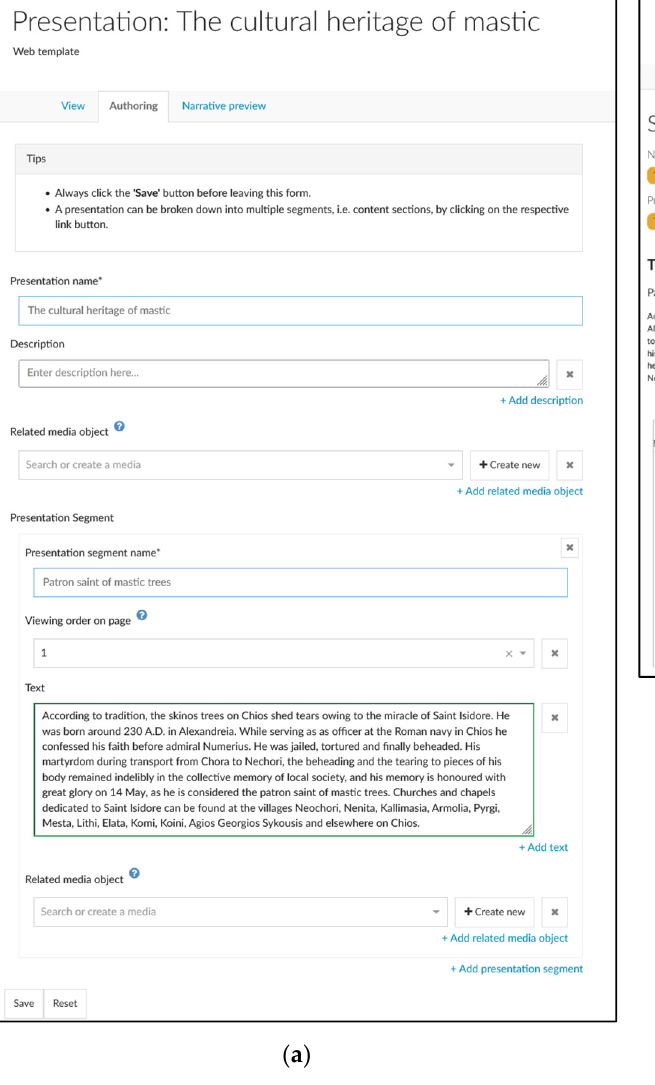
Figure 11. ( a ) Presentation authoring—“The cultural heritage of mastic”, ( b ) presentation preview.